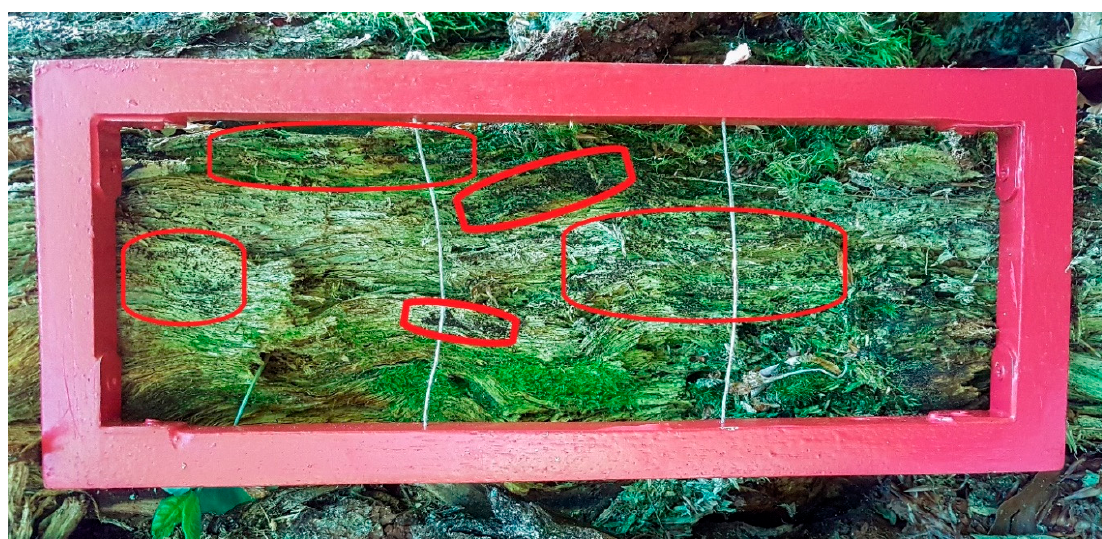
Figure 8. A grid of 30 cm × 10 cm placed on a decaying wood. Groups of Buxbaumia viridis gemmae correspond to the small black dots whose main areas are circled in red.